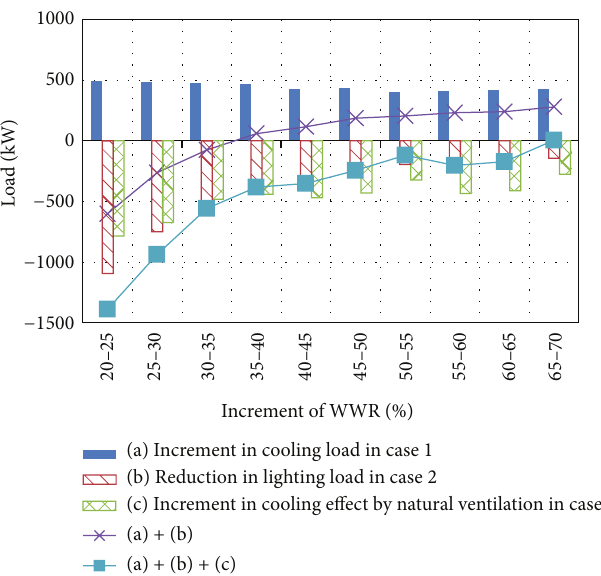
Figure 6: Influence of window